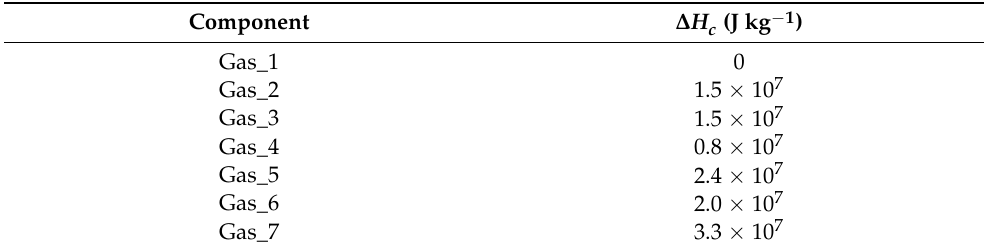
Figure 4. Mean experimental results and model predictions for the Microscale Combustion Calorimetry (MCC) tests performed on the PIR foam at 10 K min − 1 . Table 3. Heats of combustion of gaseous products of decomposition of the PIR foam. Positive ∆ H c represents an exothermic process.